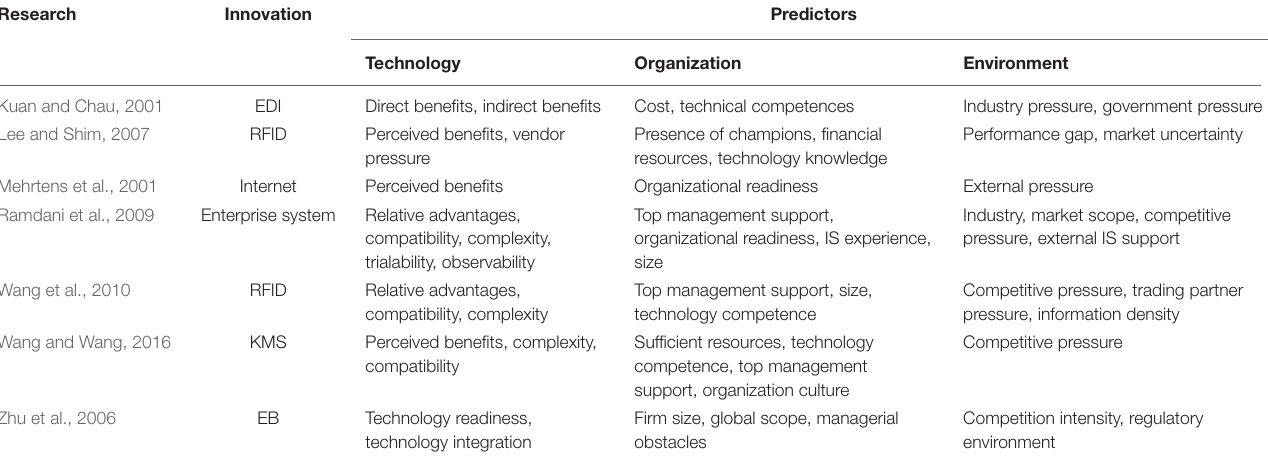
TABLE 2 | Prior studies on the TOE